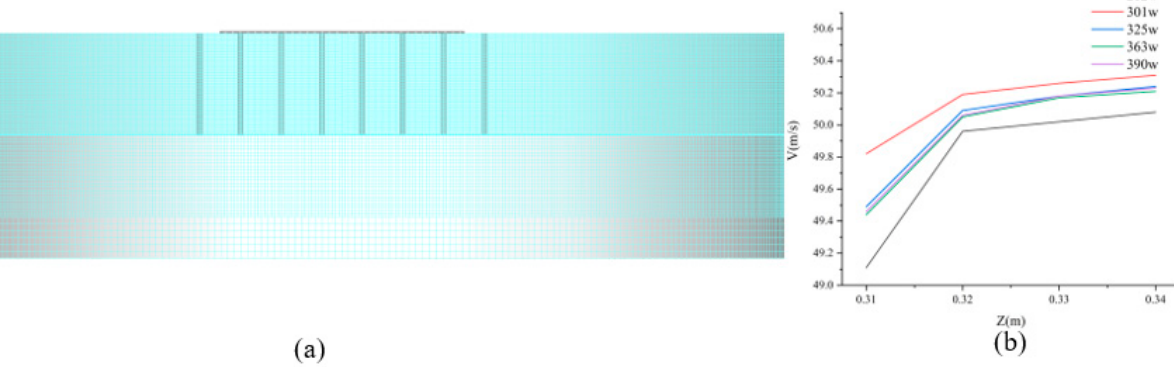
Figure 3. Mesh generation: ( a ) Mesh division; ( b ) Gas velocity below the oxygen lance at different grid numbers.